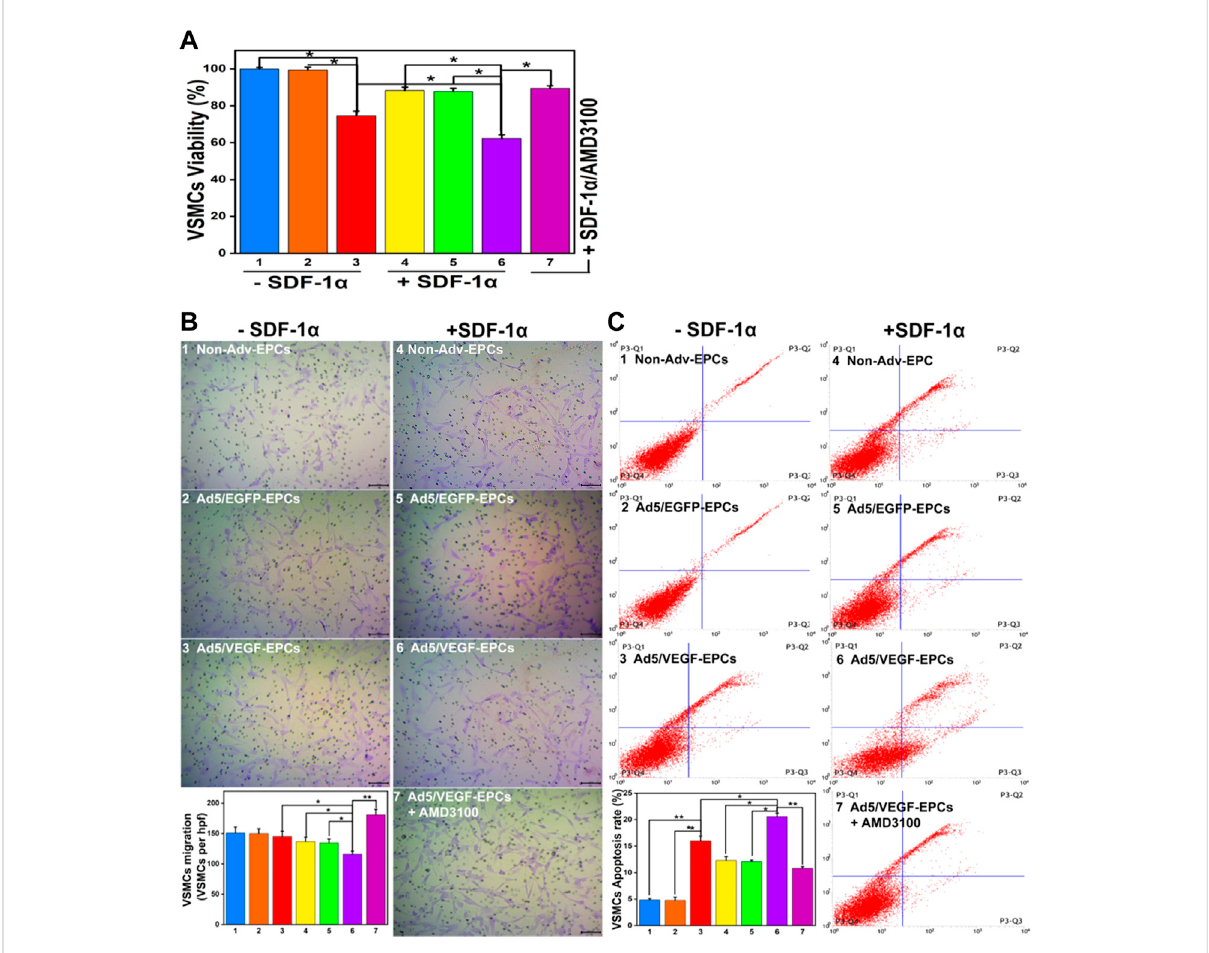
FIGURE 5 SDF-1 α decrease VSMC functionintheco-culture model. (A) Proliferationcapacity ofVSMCsindifferentgroups. (B) Migrationability ofVSMCs. (C) Apoptosis rate of VSMCs (Numbers 1 – 7 represent VSMCs and Non-Adv-EPCs; VSMCs and Ad5/EGFP-EPCs; VSMCs and Ad5/VEGF-EPCs; SDF- 1 α +VSMCs and Non-Adv-EPCs; SDF-1 α + VSMCs and Ad5/EGFP-EPCs; SDF-1 α +VSMCs and Ad5/VEGF-EPCs; SDF-1 α +VSMCs and Ad5/VEGF-EPCs + AMD3100 respectively. * p < 0.05, ** p < 0.01, n = 3 per